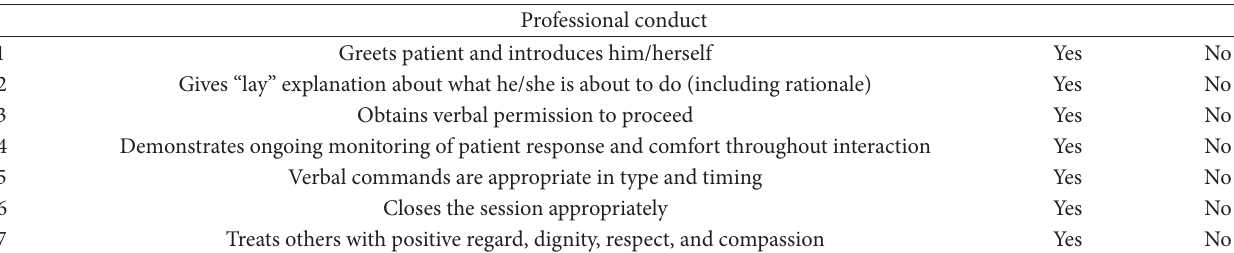
Table 1: Professional behaviour checklist items for PSEs.